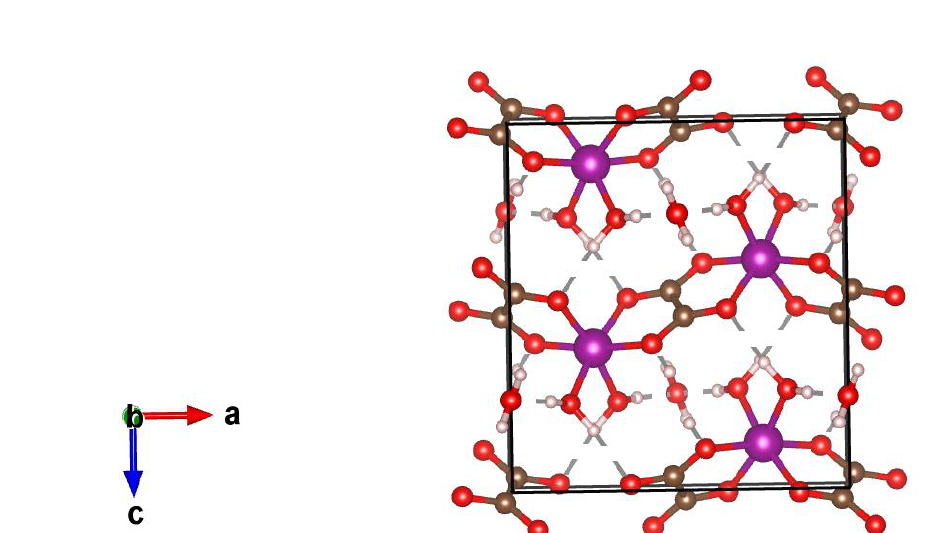
Figure 3: Water molecules